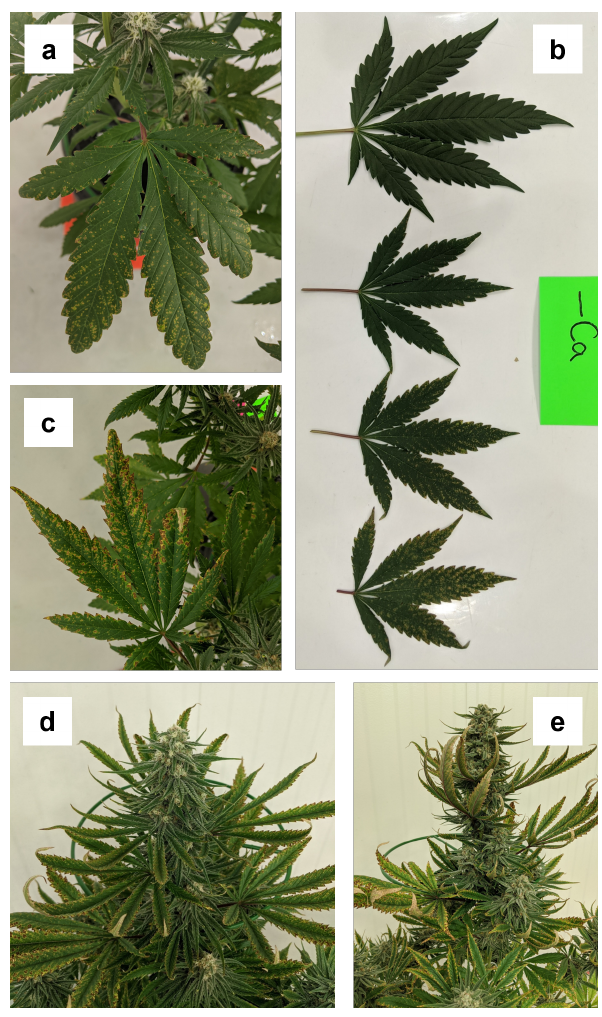
Figure 5. Progression of calcium (Ca) deficiency, ( a ) starting on lower fan leaves in week three, with severity of symptoms being concentrated near leaf margins ( b ). By week five there was general leaf margin necrosis on lower fan leaves ( c ) an upper fan and sugar leaves started to show symptoms ( d ). By week six, the majority of fan and sugar leaves showed characteristic leaf margin necrosis and upper leaves were curled upwards ( e